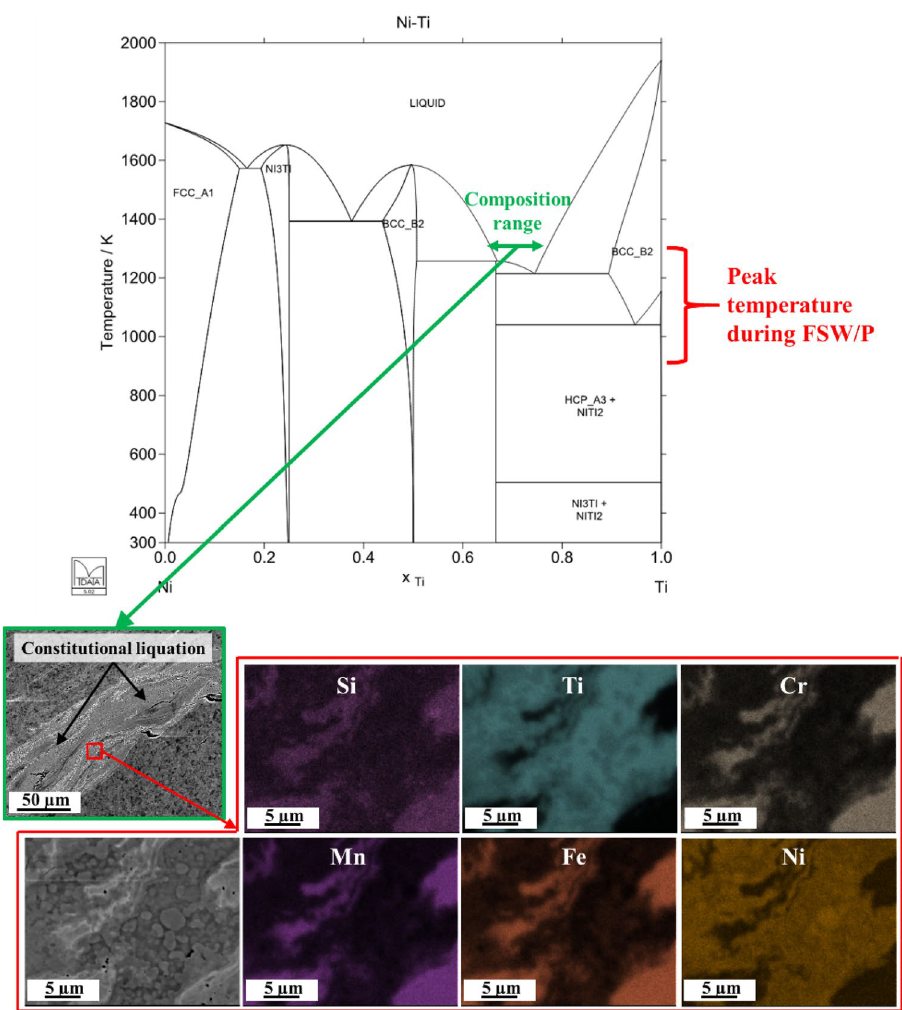
Figure 2. Phase diagram of Ni–Ti and SEM image and EDS map on processed region after one pass FSA displaying that constitutional liquation occurred during